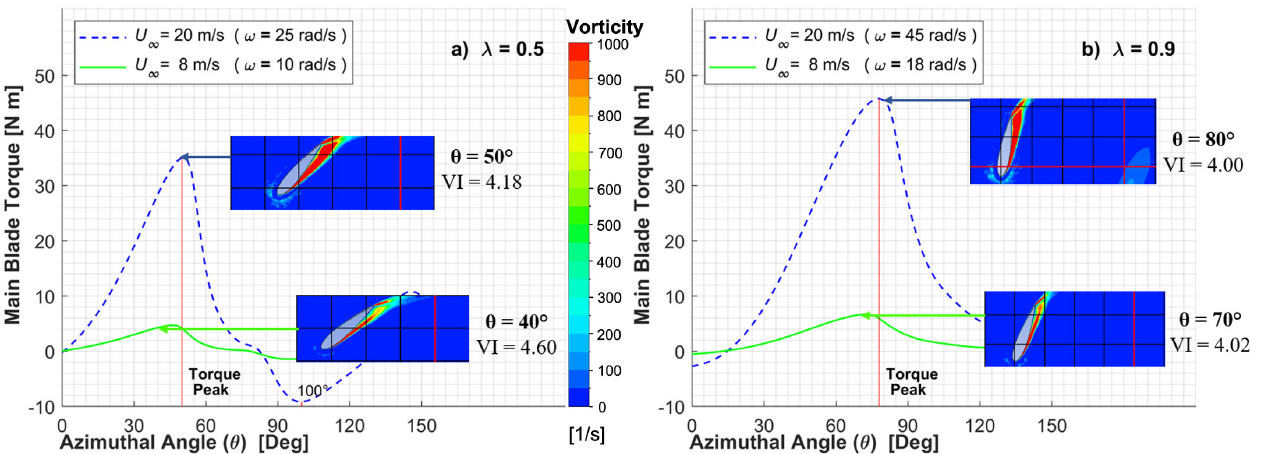
Figure 18. LE Vorticity and VI Values for Blade 1 at Various Azimuthal Angles for U ∞ = 20 m/s at λ =0.5 and λ =0.9.